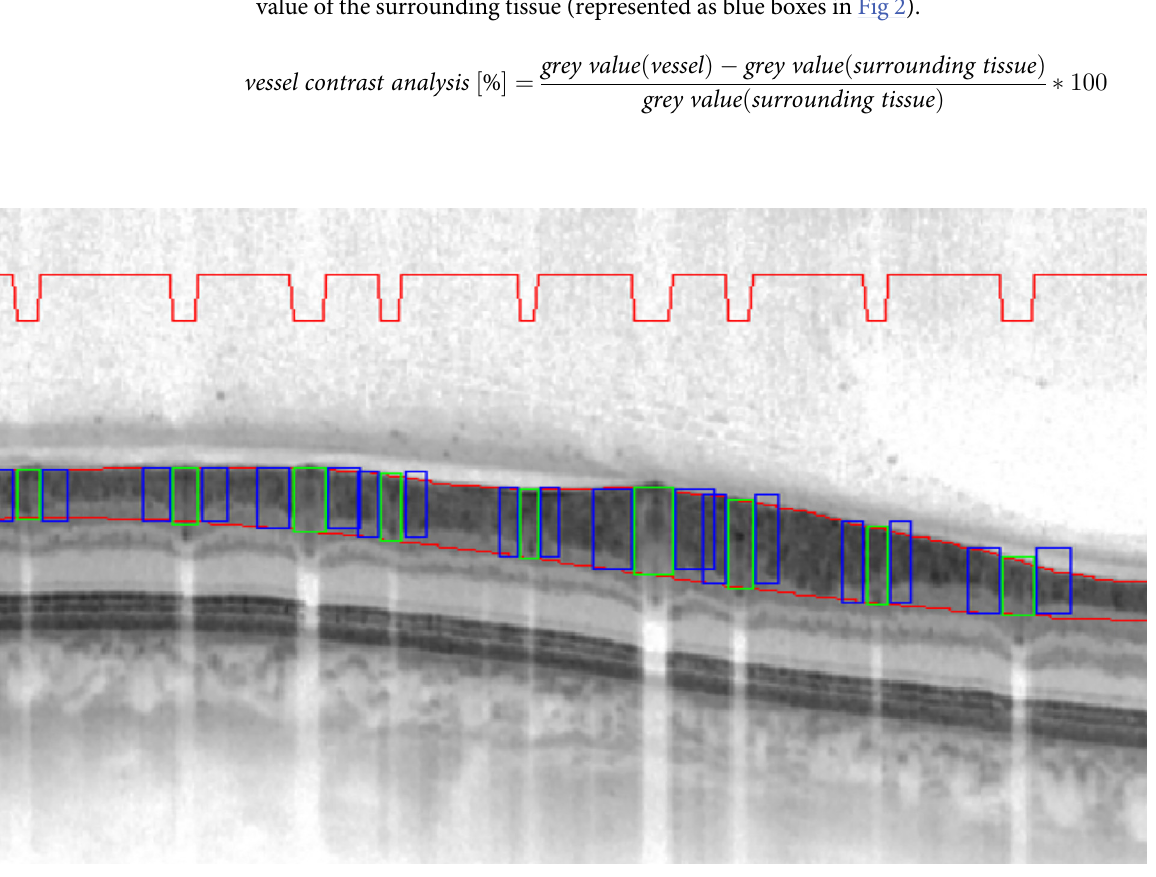
Fig 2. SD-OCT-based vessel analysis. The red line symbolises the detected vessels; the line drops when there is a vessel in the SD-OCT scan. The grey value of the vessel is measured, and depicted as the green box. This is compared to the grey value of the surrounding tissue, represented as blue